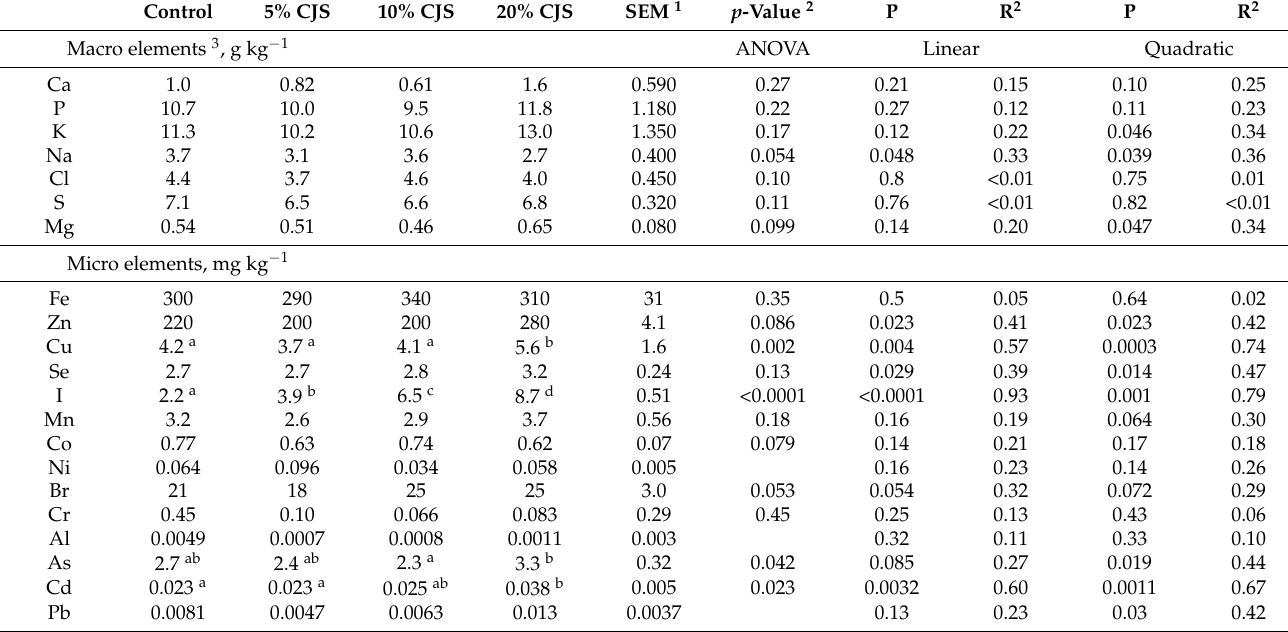
Table 7. Macro and micro minerals present in the kidney of Atlantic salmon ( Salmo salar ) from the retention experiment where salmon were fed increasing dietary level of Cyberlindnera jadinii (CJS).